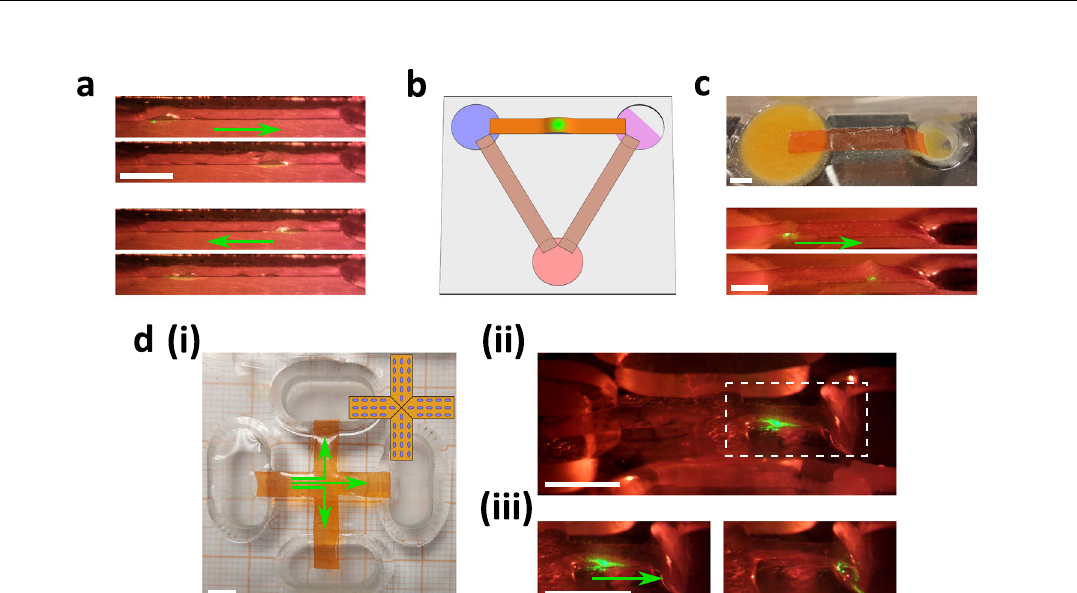
Fig. 4 | Volumeoptimisationfor different sizes ofstimulipro fi les at fi xedpeak intensity. a Comparison of the volumes measured experimentally using peak intensity of I m =4.61W/cm 2 , and volumes predicted using Gaussian stimulus.